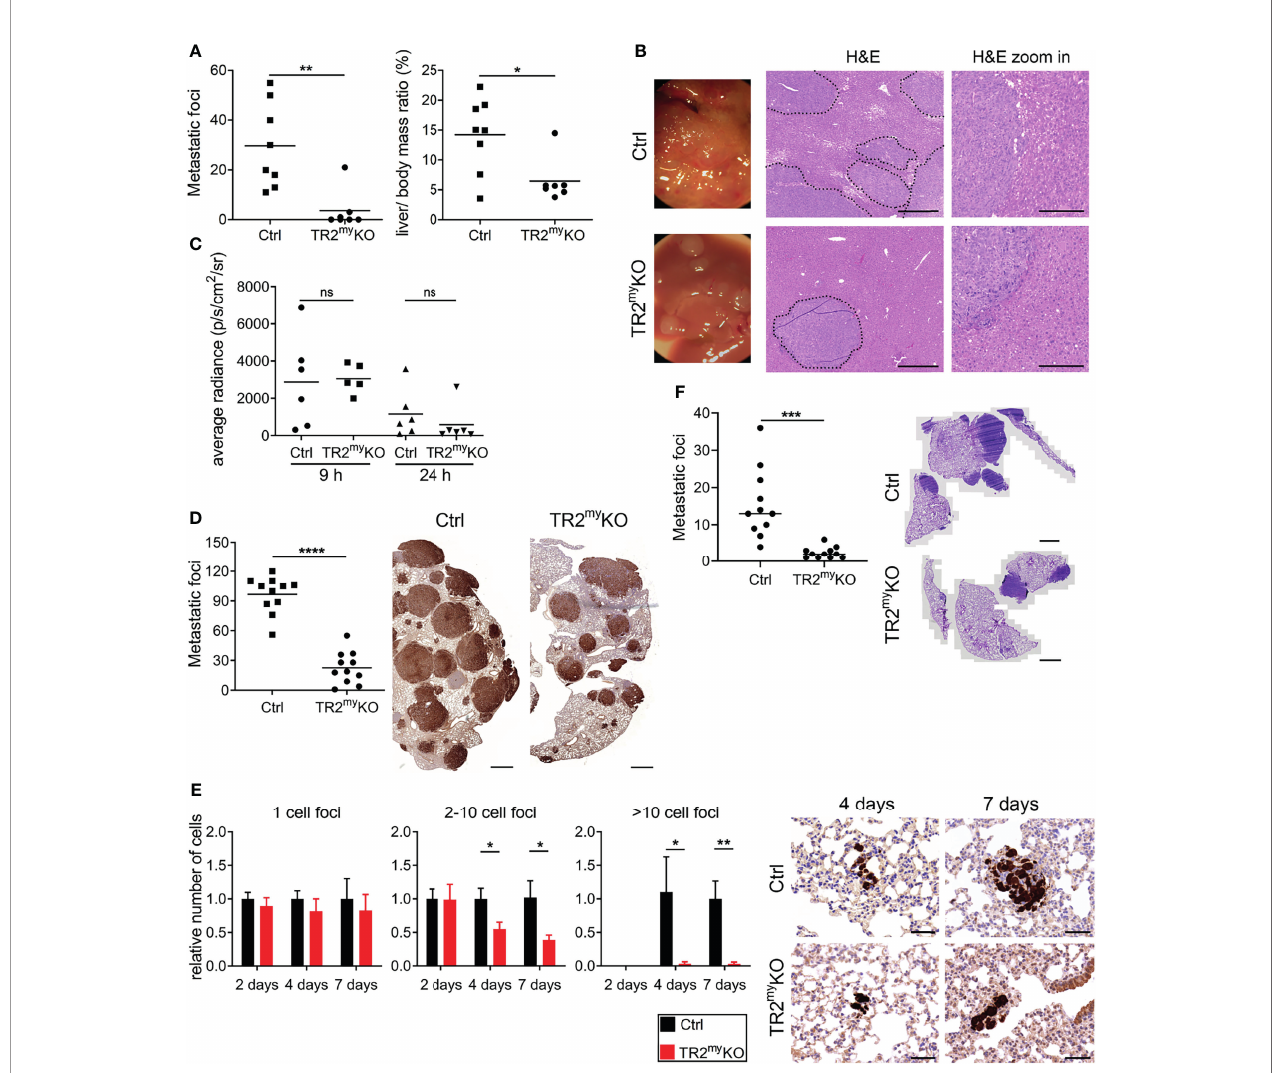
FIGURE 1 | Attenuation of liver and lung metastases in mice with myeloid cell-deletion of Tgfbr2. (A) Macroscopic quanti fi cation of liver metastatic foci and the ratio of liver weight to the total body mass (%) in TR2 my KO and control (Ctrl) mice 28 days after the intraspenic injection of MC-38GFP cells. (B) Representative macroscopic liver images and hematoxylin/eosin (H&E) stained liver sections indicating liver metastasis. Dotted line represents the edge of metastatic foci (middle panel). Bar = 500 m m; bar zoom-in = 200 m m. (C) Liver seeding of MC-38 luciferase-expressing cells determined at 9 and 24 hours post-intrasplenic injection of MC- 38 luciferase cells using quanti fi cation of luciferase signal in the perfused liver. (D) Macroscopic quanti fi cation of lung metastasis in TR2 my KO compared to control (ctrl) mice 30 days after intravenous injection of MC-38GFP cells. Representative images (right panel) of pulmonary metastasis stained with anti-GFP antibodies (brown). Bar = 1 mm. (E) Quanti fi cation of GFP + cells in lung sections at 2, 4 and 7 days post-tumor cell injection as tumor cell clusters divided into: 1 cell, 2-10 cell foci and >10 cell foci. Representative images of lung sections from day 4 and 7 stained for GFP (brown). n = 4-6 mice per time point and genotype. Bar = 50 m m. (F) Spontaneous lung metastasis of LLC1.1 cells subcutaneously injected in TR2 myelo KO and Ctrl mice terminated at days 32. Representative H&E stained lung sections of respective genotype. Bar = 1 mm. For panels (A – D, F) each dot represents a mouse. Statistical signi fi cance was assessed using Mann-Whitney t-test: ns, not signi fi cant; *p < 0.05; **p < 0.01; ***p <